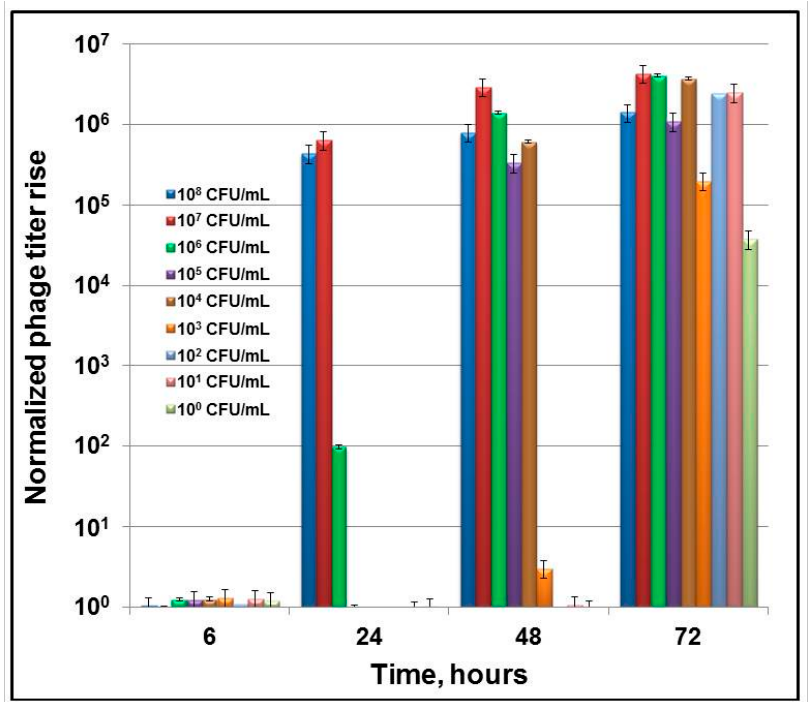
Figure 2. Dynamics of phage S708 growth on B . abortus S19 detected by qPCR. An overnight culture of B . abortus S19 was diluted to OD 600 = 0.1 in Brucella Broth. 20 mL of each serial bacterial dilution from 10 0 to 10 − 8 (circa 10 8 to 10 0 CFU/mL, respectively) was made in Brucella Broth. Diagnostic bacteriophage S708 was added to each aliquot to a final concentration of 10 3 PFU/mL, and the sample was incubated in a shaker incubator at 37 °C and 60 rpm. 500 µL samples were withdrawn after 0, 6, 24, 48, and 72 h of incubation, treated with 10% chloroform and centrifuged to remove cell debris. 1 µL of each sample, neat or diluted 1:100 with Brucella Broth, was used for qPCR analysis. Reaction mixes were prepared in a total volume of 10 µL including 5 µL of the master mix and 0.3 µM of each primer. The cycling parameters were: 95 °C, 5 min; 40× (95 °C, 20 s; 60 °C, 60 s) with fluorescence measurement at the end of each cycle.